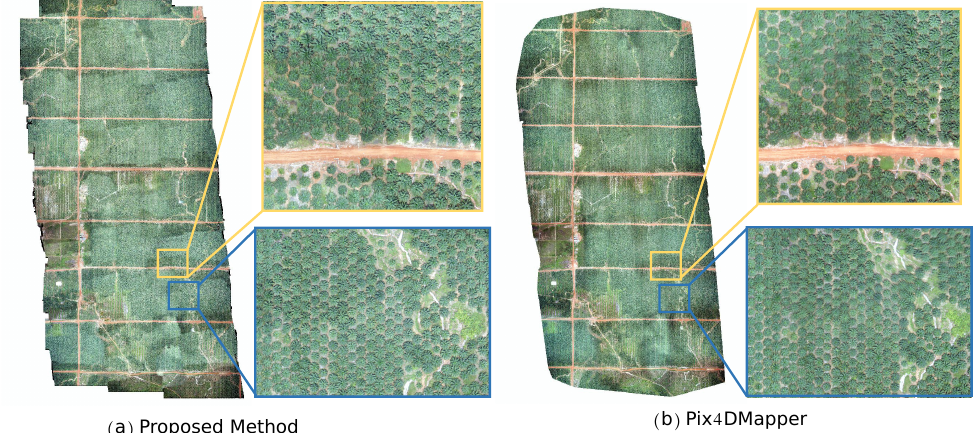
Figure 5. Orthophoto results of the proposed stitching method on the oil-palm dataset. The results show that the quality of live mosaicing is comparable to that of Pix4DMapper. Some details even show that the output live mosaic looks better than offline-based commercial construction software Pix4DMapper. The blue bounding box of Pix4DMapper shows the blur condition, which is not shown in proposed method.